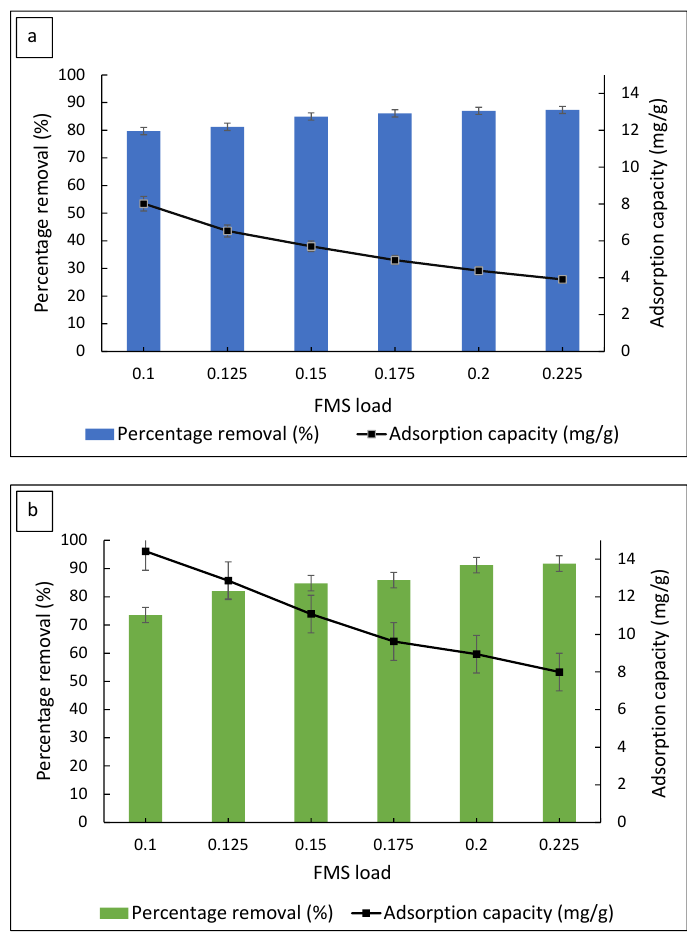
Figure 4. The effect of the FMS/PU adsorbent load on the percentage removal of ( a ) MB and ( b ) MG.